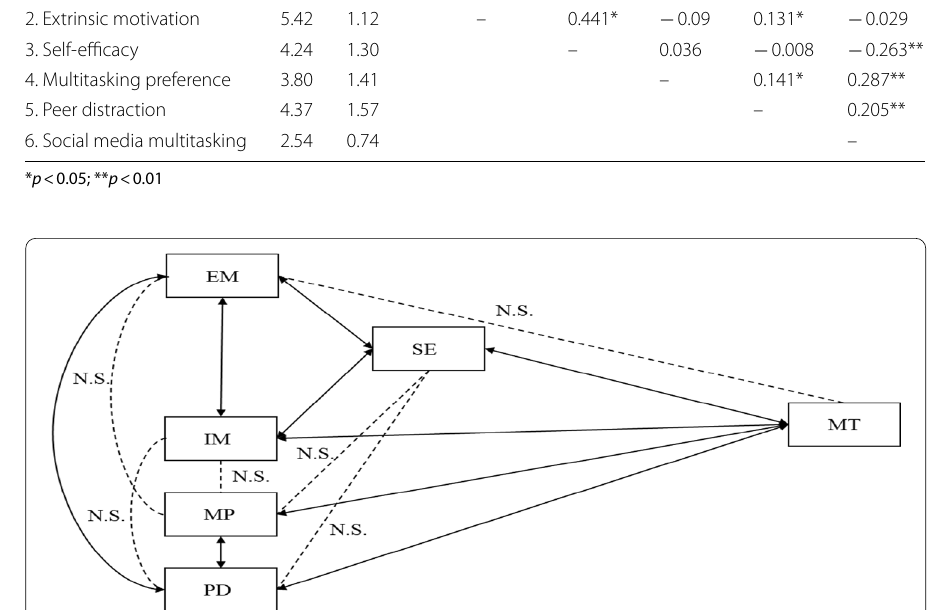
Fig. 1 Hypothesized model. EM external motivation, IM internal motivation, SE self-efficacy, MP multitasking preference, PD peer distraction, MT off-task socialmedia